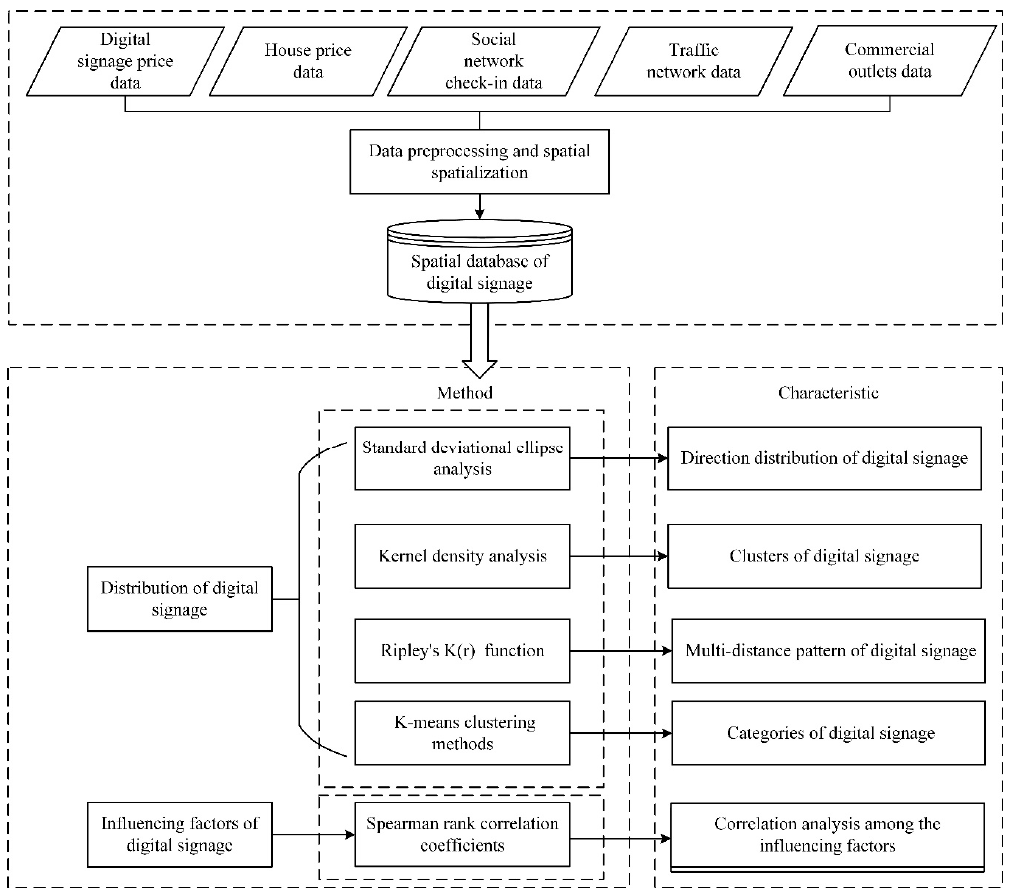
Figure 2. the workflow of the research. Figure 2. The workflow of the